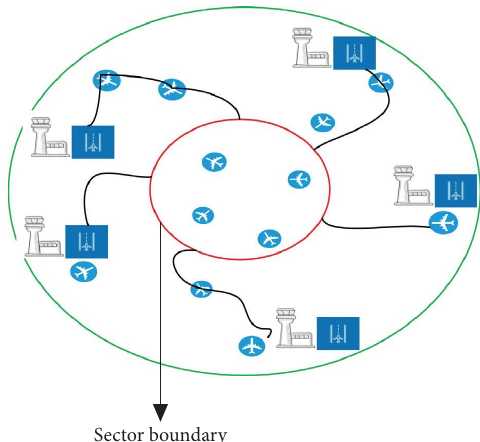
Figure 1: Schematic diagram of controlling air trafc situation in a